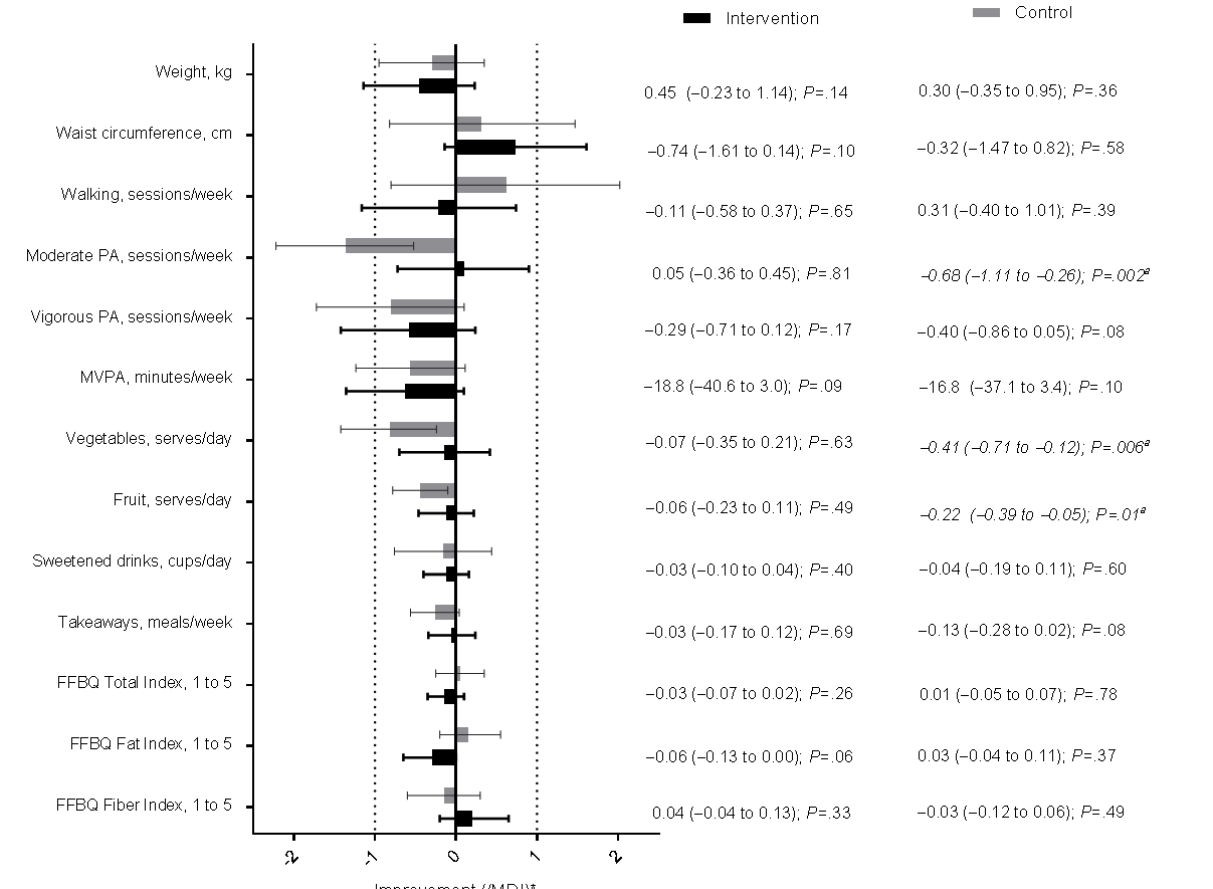
Figure 2. Mean changes (95% CI) over first 6 months of noncontact in study outcomes plotted as multiples of the minimum differences of interest (MDI) in the Get Healthy, Stay Healthy (GHSH) intervention (n=114) and control (n=114) groups ("a" indicates significant change, P <.05. Asterisk indicates that the x-axis values for the means and CI are displayed as the mean, upper limit, and lower limit by the MDI value). FFBQ: Fat and Fiber Behavior Questionnaire; PA: physical activity.